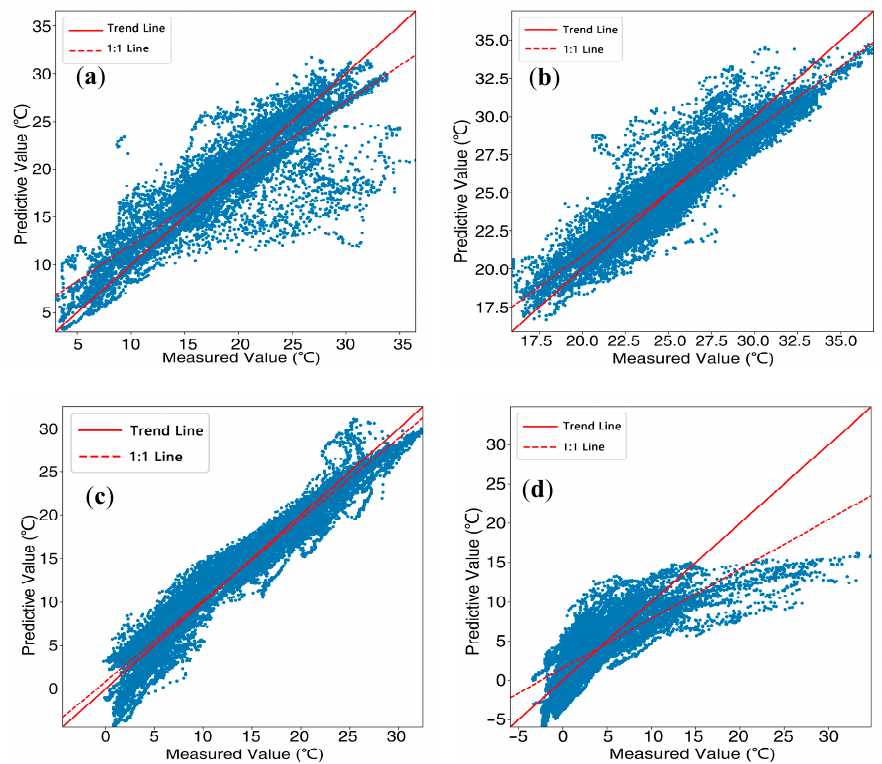
Figure 2. Prediction model of temperature based on the BP neural network. ( a ) Spring. ( b ) Summer. ( c ) Autumn. ( d ) Winter.